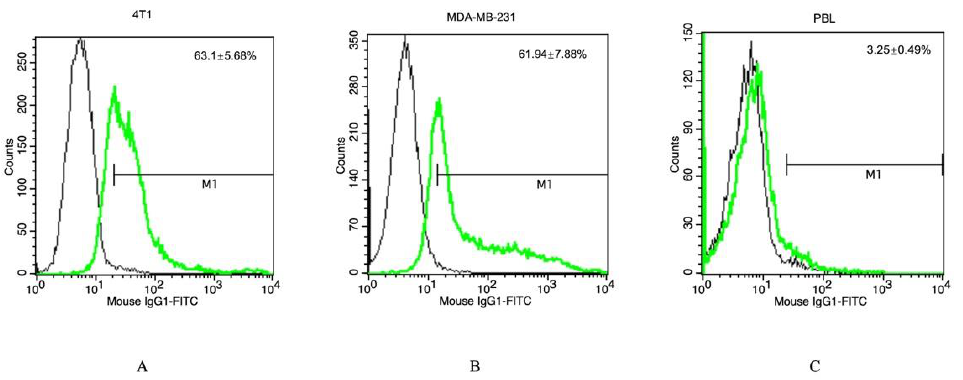
Figure 1. Representative histograms of a flow cytometric analysis of 4T1 ( A ), MDA-MB-231 ( B ) and PBL ( C ) using FITC-labeled cmHsp70.1 antibody (green line) and an isotype-matched control anti- body (black line). Values in the upper right corner of each graph represent mean values ± SD of 3 independent experiments.